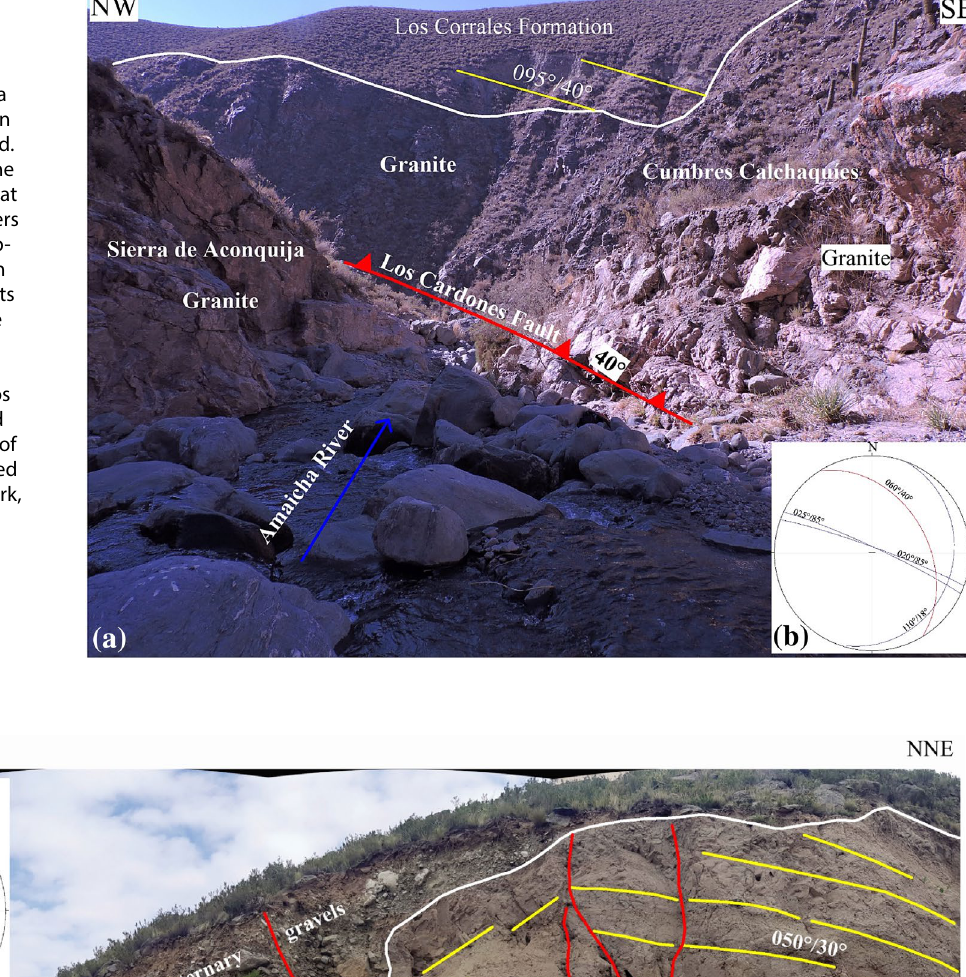
Fig. 7 a Photographic illustration in the Amaicha Valley. A reverse fault places the Andalhuala Formation on the Yasyamayo Forma‑ tion. Other faults also affect quaternary gravels. The white lines mark the contacts of the sedimentary units. Yellow lines indicate bedding. Red lines are identifying structures. On the lower right